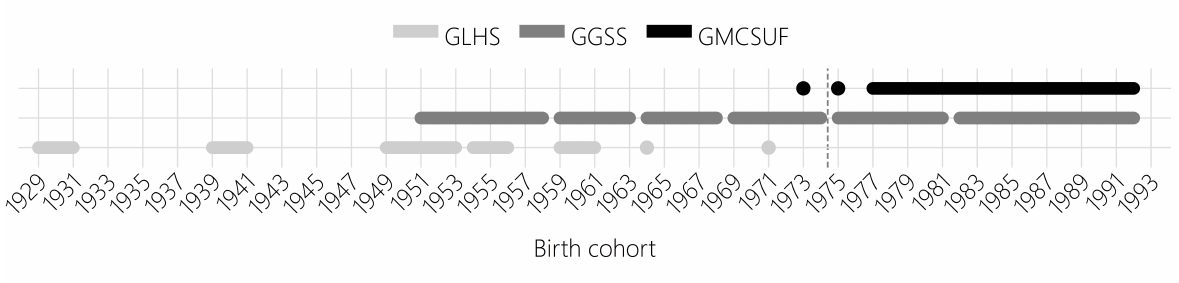
Figure 1: Classification of birth cohorts across different